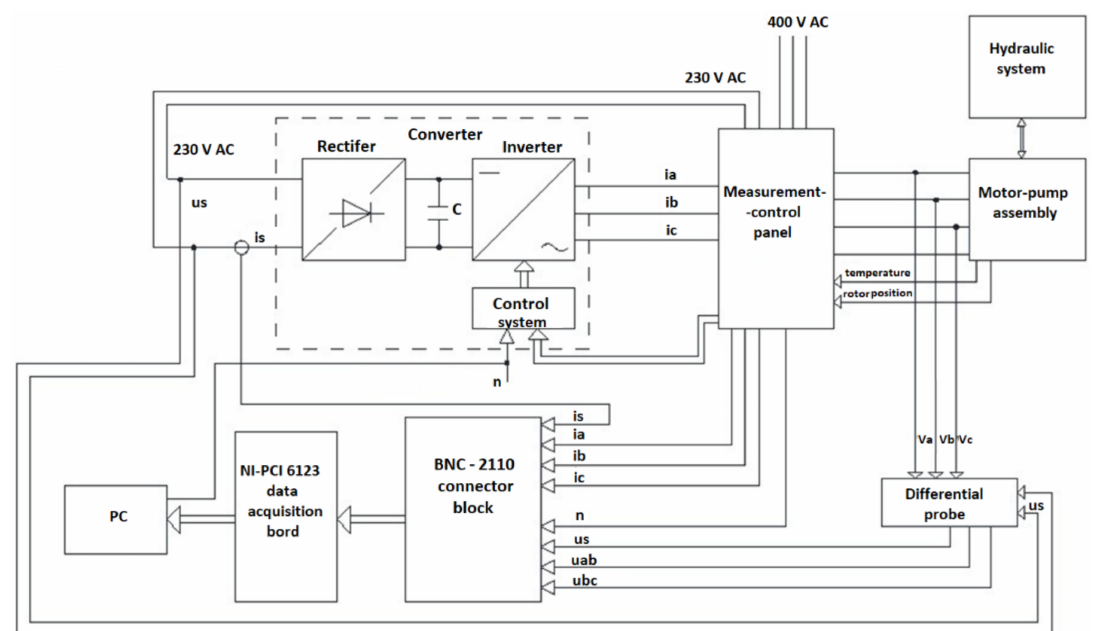
Figure 8. Diagram of the system for measuring electrical quantities of the motor-pump unit. is— converter current, us—supply voltage, ia, ib, ic—phase currents, va, vb, vc—potentials of the phases a, b, and c, uac, ubc—line-to-line voltages, and